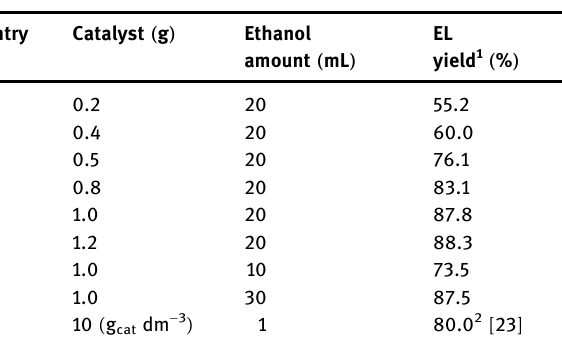
Table 1: E ff ects of catalyst dosage and solvent amount on